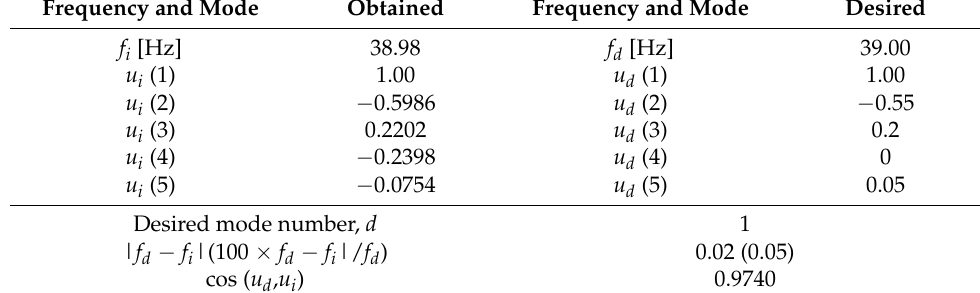
Figure 22. Original FRFs and FRFs after the addition of mass-spring substructures. Table 14. Comparison of natural frequencies and mode shapes. Frequency and Mode Obtained Frequency and Mode Desired